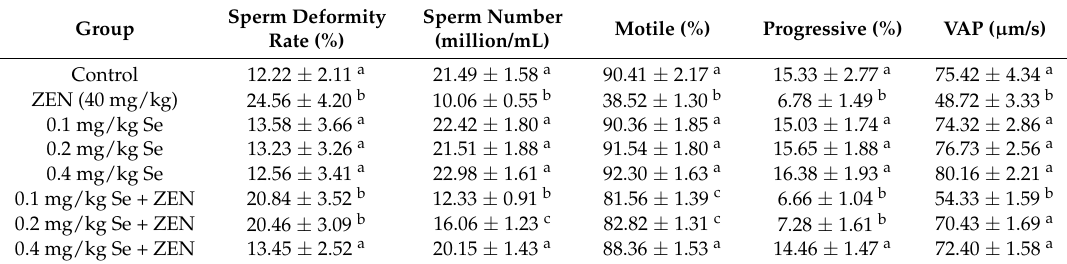
Table 3. Effect of Se on sperm deformity rate, sperm concentration and sperm motility in mice induced by ZEN.